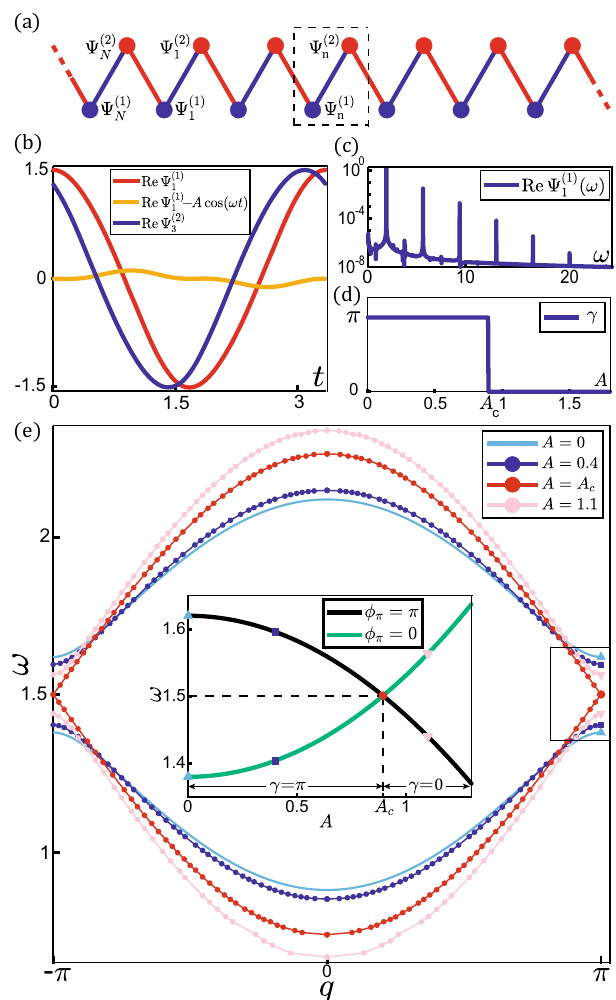
Fig. 1 The minimal model of nonlinear SSH chain. a Schematic illustration of the lattice subjected to PBC. Unit cell is enclosed by black dashed box. Red and blue bonds represent intra-cell and inter-cell couplings. b A nonlinear bulk mode computed by shooting method 62 – 64 with amplitude A = 1.5 and wave number q = 4 π /5. Red and blue curves are the wave functions of n = 1 and 3 sites, respectively. Orange curve shows the noticeable difference between nonlinear mode and sinusoidal function. c Frequency pro fi le of nonlinear bulk mode in ( b ). d Numerical computation of the amplitude dependence of nonlinear Berry phase in Eq. (3). The algorithmic details are elaborated in SI. II.C. ( e ), nonlinear band structures ω = ω ( q , A ) plotted for bulk mode amplitudes from A = 0 to 1.1. The red curves touch for the topological transition amplitude A c = 0.8944 at ω = ϵ = 1.5. The inset elaborates on the gap-closing transition amplitude 0 A c at which band inversion